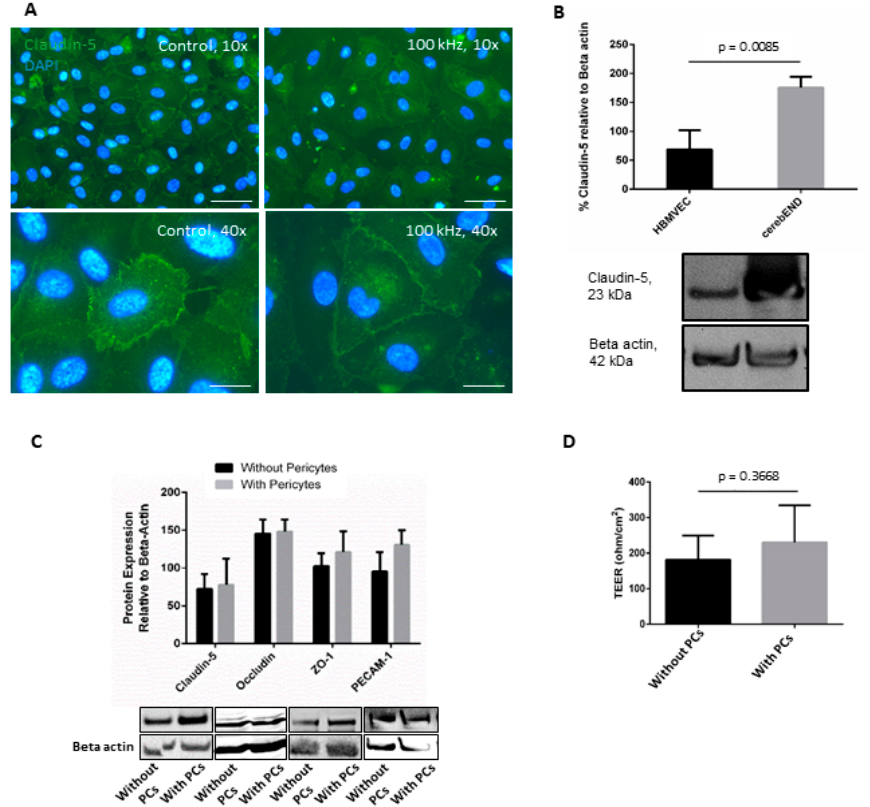
Figure 1. The addition of pericytes to culture increased HBMVEC barrier properties. ( A ) HBMVEC monoculture subjected to TTFields at 100 kHz for 72 h. Images shown are representative of at least three independent experiments. Scale bar = 200 µm ( B ) Western blot and densitometric analysis thereof, showing the difference of claudin-5 expression in untreated HBMVEC and cerebEND, n = 3. ( C ) Expression of tight junctional proteins in HBMVEC cultured alone or in combination with human pericytes (PCs) was demonstrated via Western blot and corresponding densitometric analyses, n = 3. The western blots shown are representative of at least three independent experiments. ( D ) Transendothelial electrical resistance (TEER) measurements of HBMVEC cells in monoculture or co-culture with pericytes, n = 6. Error bars represent the standard deviation.